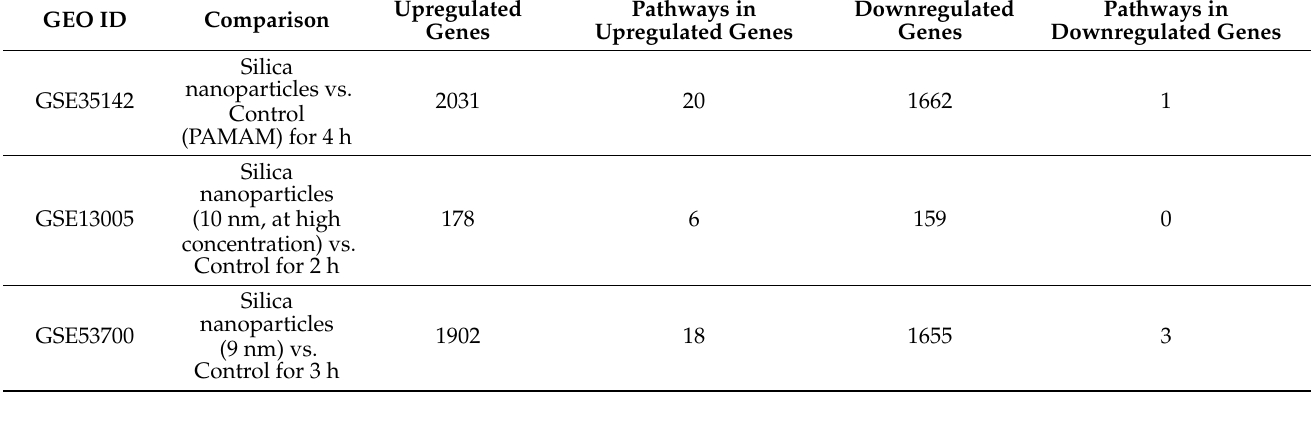
Table 1. Number of up-regulated/down-regulated genes and enriched pathways (FDR < 0.05) identified from three microarray data sets.